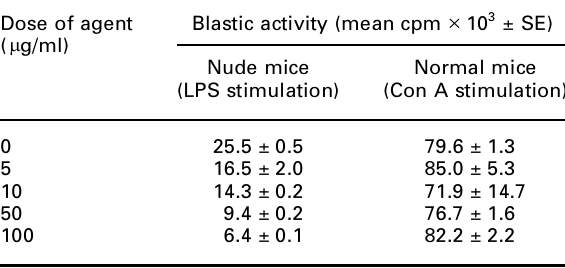
Table 1. Influence of IPD–1151T on blastic activity of spleen cells in response to mitogenic stimulation a Dose of agent ( m g/ml)